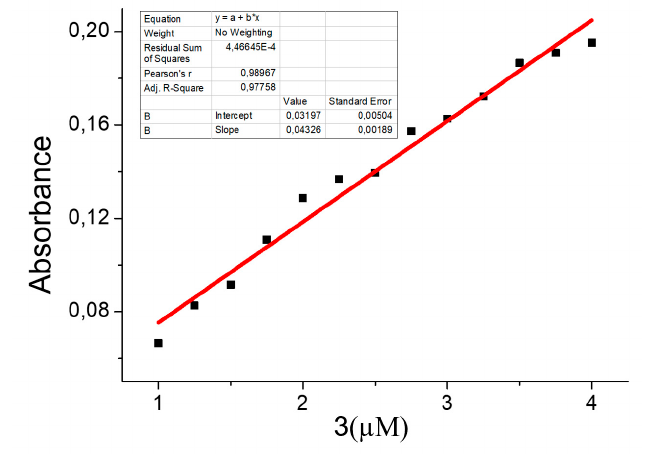
Figure 12. Calibration curve for Hg 2 + at di ff erent